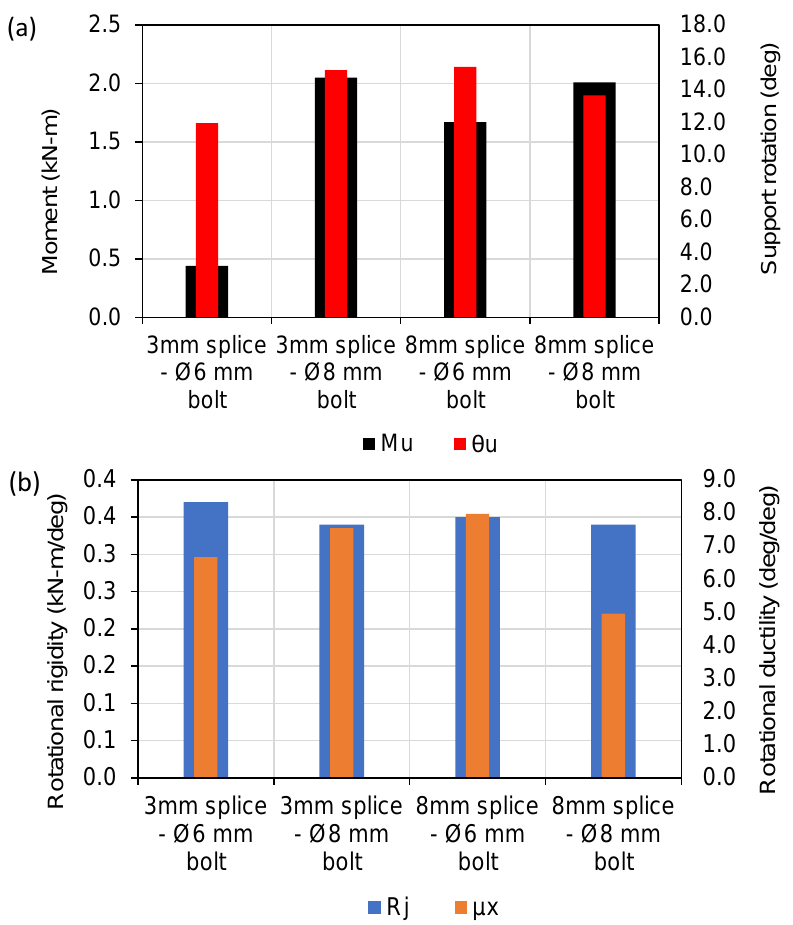
Figure 11. Comparison among ( a ) bending moment and support rotation, ( b ) rotational rigidity and rotational ductility of steel spline connections with variation in steel plate thickness and bolt diameter.